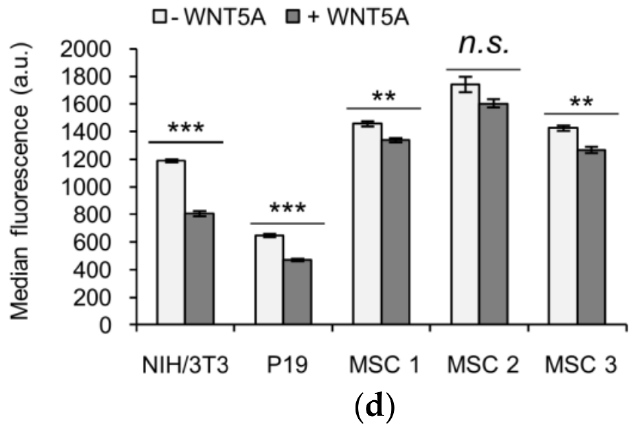
Figure 5. KIF26B-C as a functional reporter for profiling WNT5A signaling activity in somatic and stem cell lines. ( a ) Flow cytometry histograms depicting the degradation response of the lentiviral GFP-KIF26B-C reporter in NIH/3T3 cells after WNT5A stimulation (a.u. = arbitrary units); ( b ) Flow cytometry histograms depicting the degradation response of the lentiviral GFP-KIF26B-C reporter in P19 cells after WNT5A stimulation. Dotted trace indicates the autofluorescence of the control, uninfected cells (a.u. = arbitrary units); ( c ) Flow cytometry histograms depicting the degradation response of the lentiviral GFP-KIF26B-C reporter in three independent lines of primary human MSCs after WNT5A stimulation. Dotted trace indicates the autofluorescence of the control, uninfected cells (a.u. = arbitrary units); ( d ) Quantification of ( a – c ) (a.u. = arbitrary units). Error bars represent ± SEM calculated from independent replicates ( n = 3 for NIH/3T3, P19; n = 4 for MSC 1, 2 and 3). Statistical analysis was performed with unpaired t -test ( n.s. = not significant; *** p value < 0.001; ** p value <